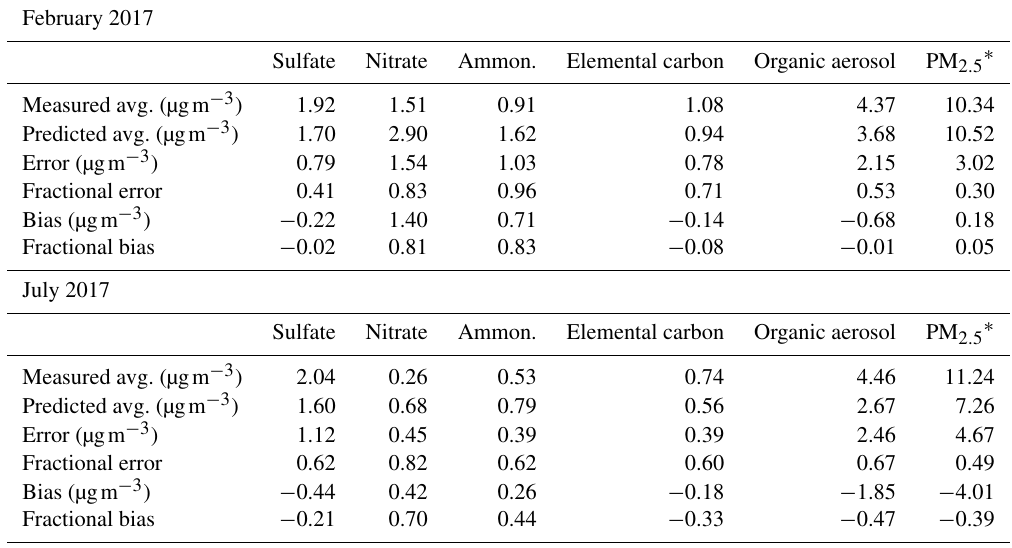
Table 1. Comparison of daily average high-resolution PMCAMx-v2.0 predictions with daily EPA-CSN measurements during February